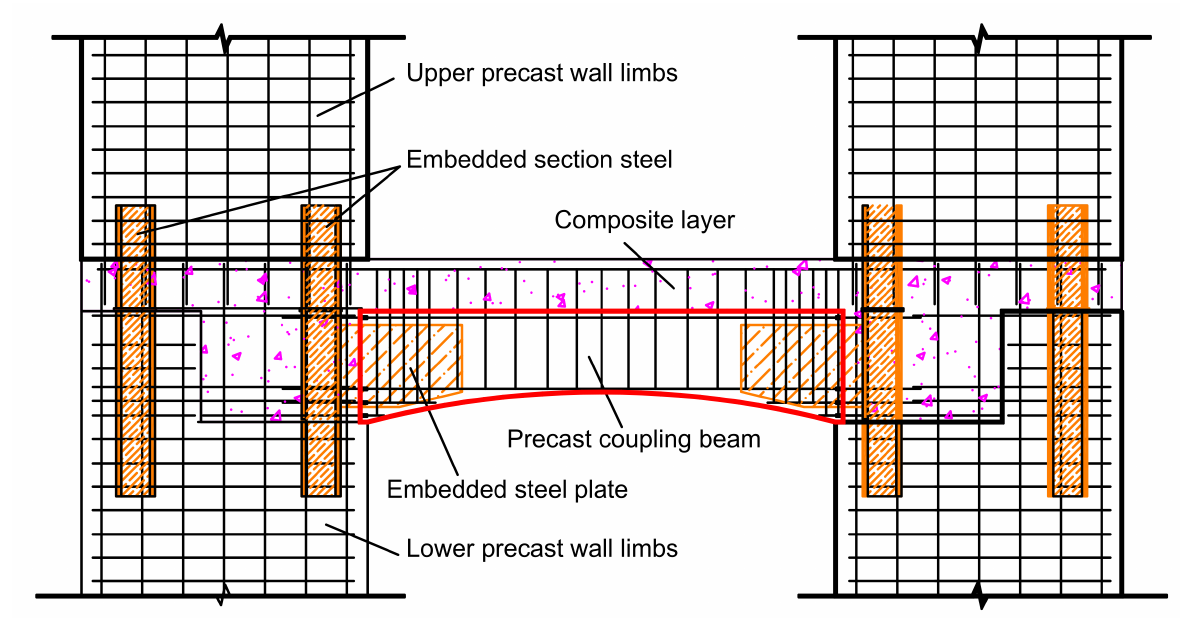
Figure 1. Schematic of shear walls connected with a prefabricated arch coupling